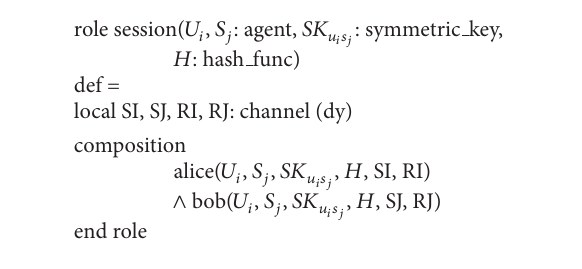
Algorithm 5: Role specification in HLPSL for the session of our